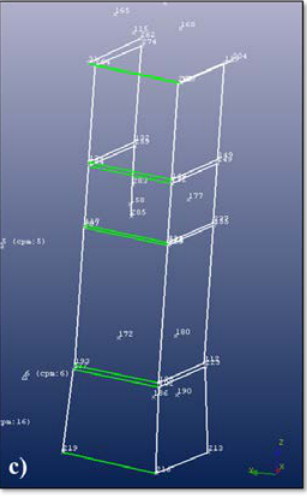
Figure 5. Phases of the 3D model photogrammetric